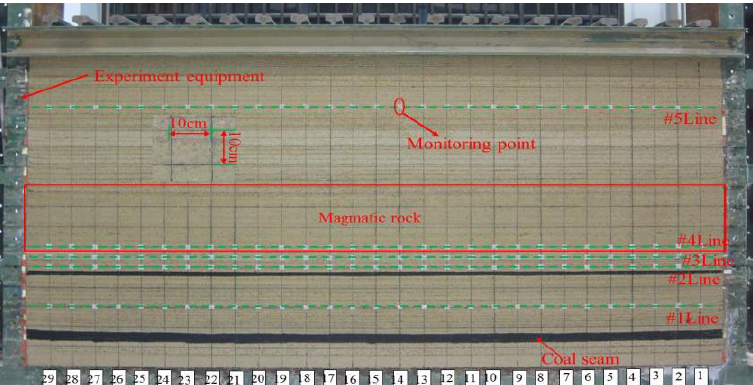
Figure 2. Similar simulation test model and monitoring line and point layout.